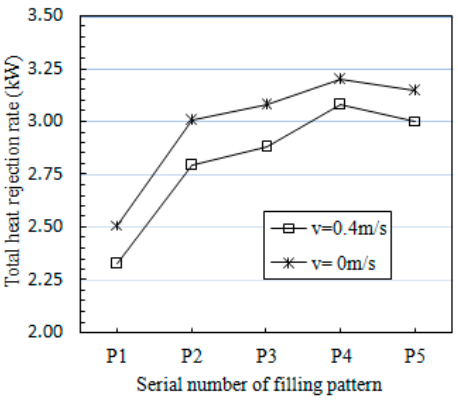
Figure 6. Relationship curves between total heat rejection and filling layout patterns under 0.4 m/s crosswind speed conditions. Operating conditions: 60 °C, 6 L/min.